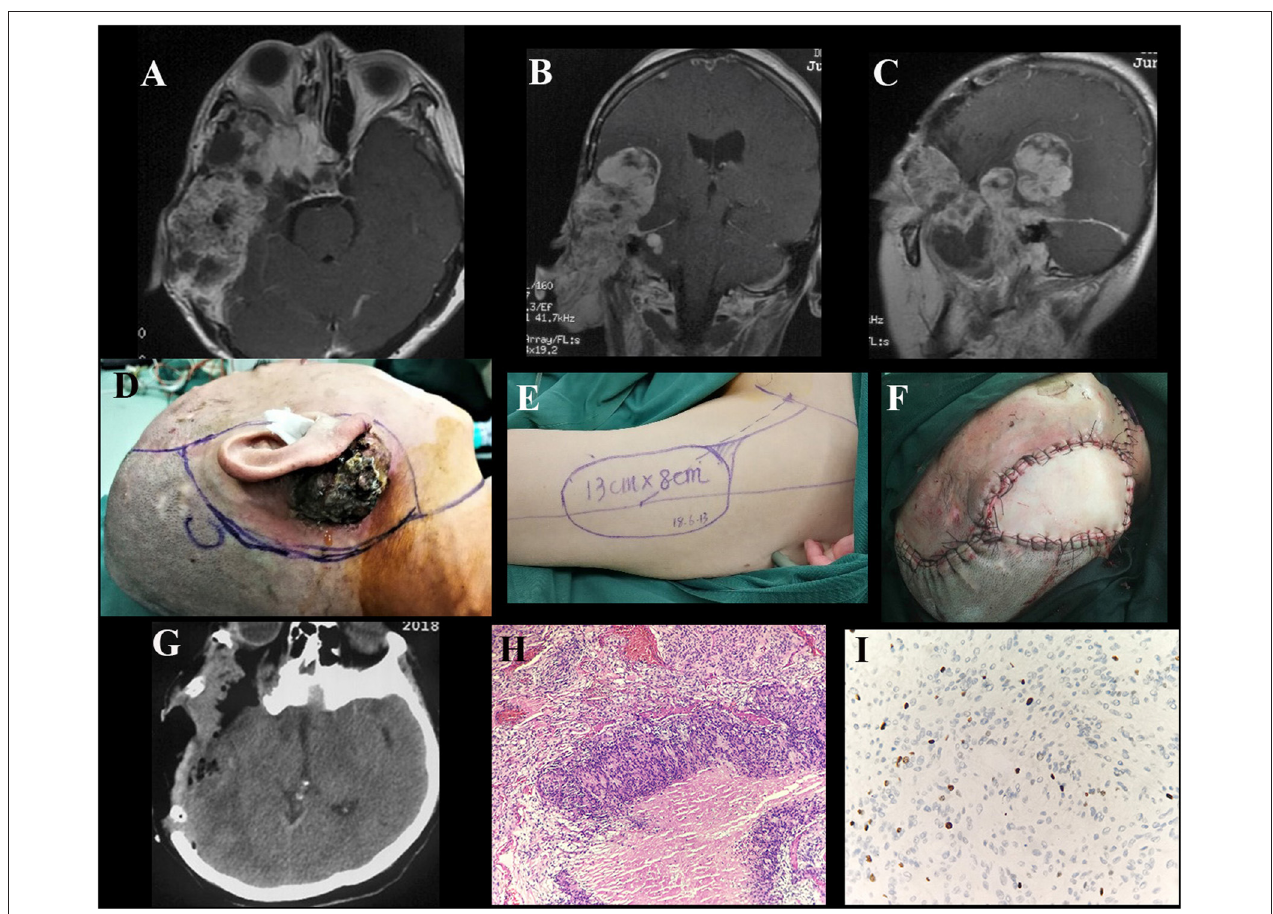
FIGURE 7 | Case illustrating an undefined approach. (A–C) T1-weighted axial and coronal contrast-enhanced MRIs demonstrate an irregularly shaped tumor originating in the right middle skull base with both intra- and extra-cranial extensions, invading the right ear with skin ulceration. The tumor enhanced heterogeneously after injection of contrast agent. (D–F) The incision surrounding the lesion and the free flap from the anterolateral thigh harvested to repair the defect. (G) Postoperative CT scan shows tumor and bone involvement resection. (H) H&E × 100 indicate atypical meningioma (WHO grade II). (I) Immunohistochemical staining shows Ki-67 ≥ 5.